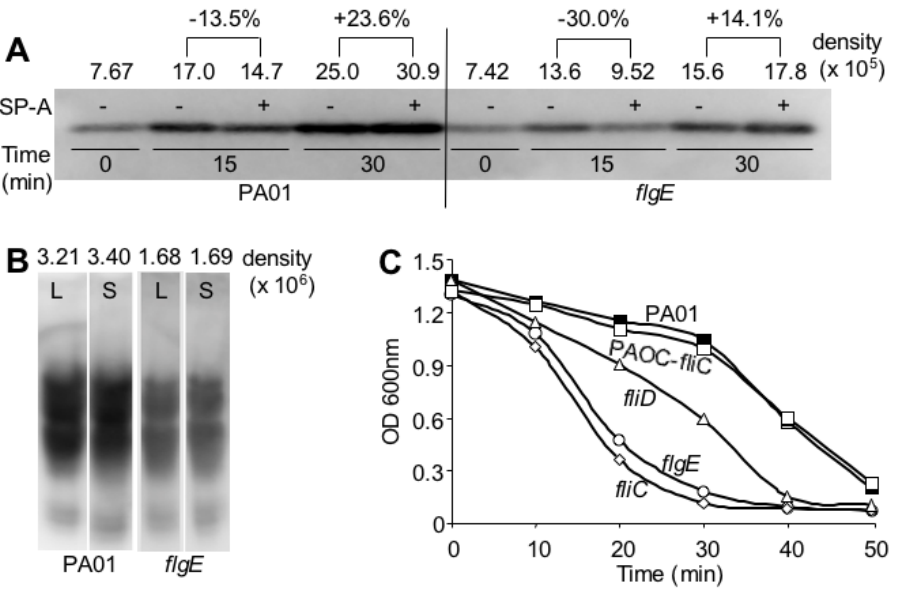
Figure 8. Mutation in theflgEGene Reduces the Ability ofP.aeruginosato Synthesize LPS Both in the Presence and in the Absence of SP-A. (A– B) The flgE mutant has reduced ability to synthesize the inner core (A) and B-band-O-antigen (B) of LPS. The induction of LPS biosynthesis was measured using a monocloncal antibody against the inner core sugars and B-band O-antigen of LPS. The fold of increase was quantified against controls using a densitometer. (C) Flagellar mutants are more susceptible to cell lysis by SDS. Wild-type PA01 and the complemented PAOC-fliC strains are more resistant to 0.25% SDS than the flagellum-deficient mutants flgE, fliC and fliD . Experiments were repeated five times with similar results. The results from one typical experiment are